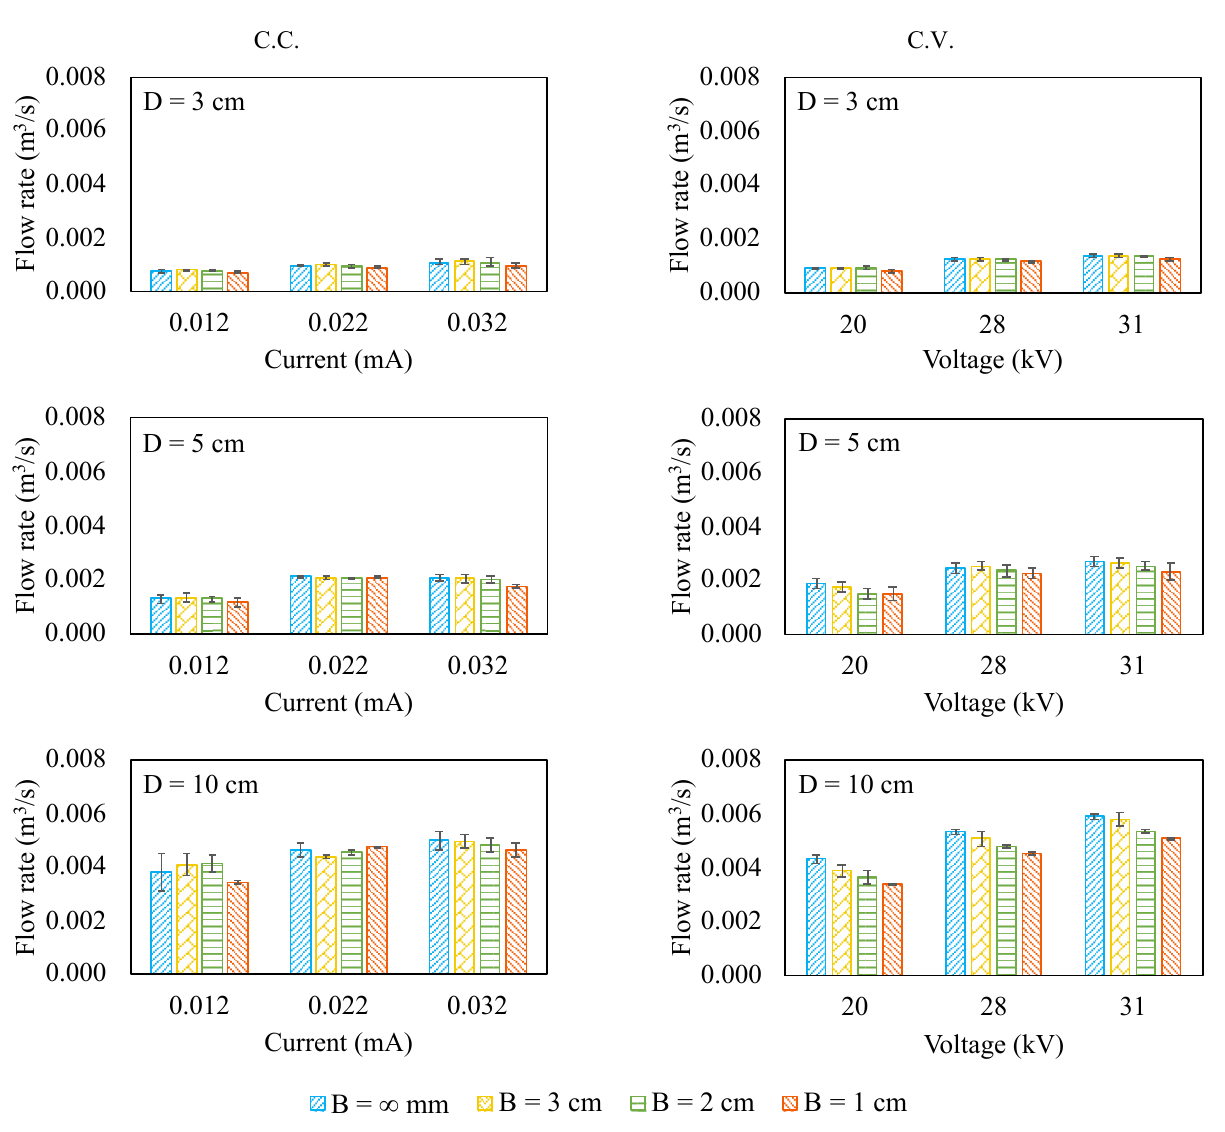
Figure 3. The flow rate for the ionic wind pump under test.